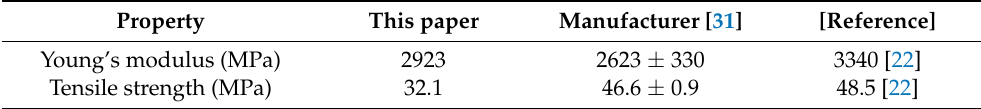
Table 2. Comparison of basic mechanical properties of PLA specimens.